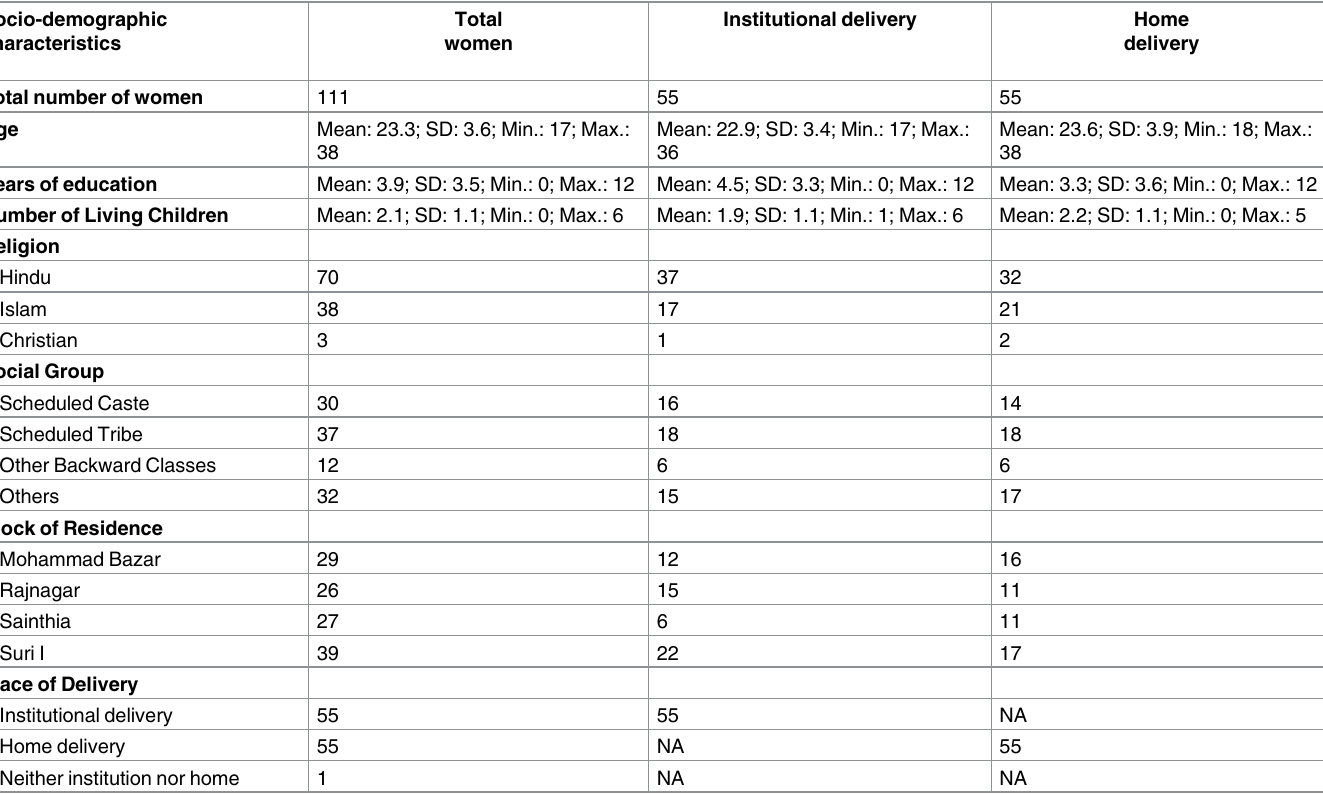
Table 1. Socio-demographic characteristics of women selected for focus group discussion, stratified by the place of